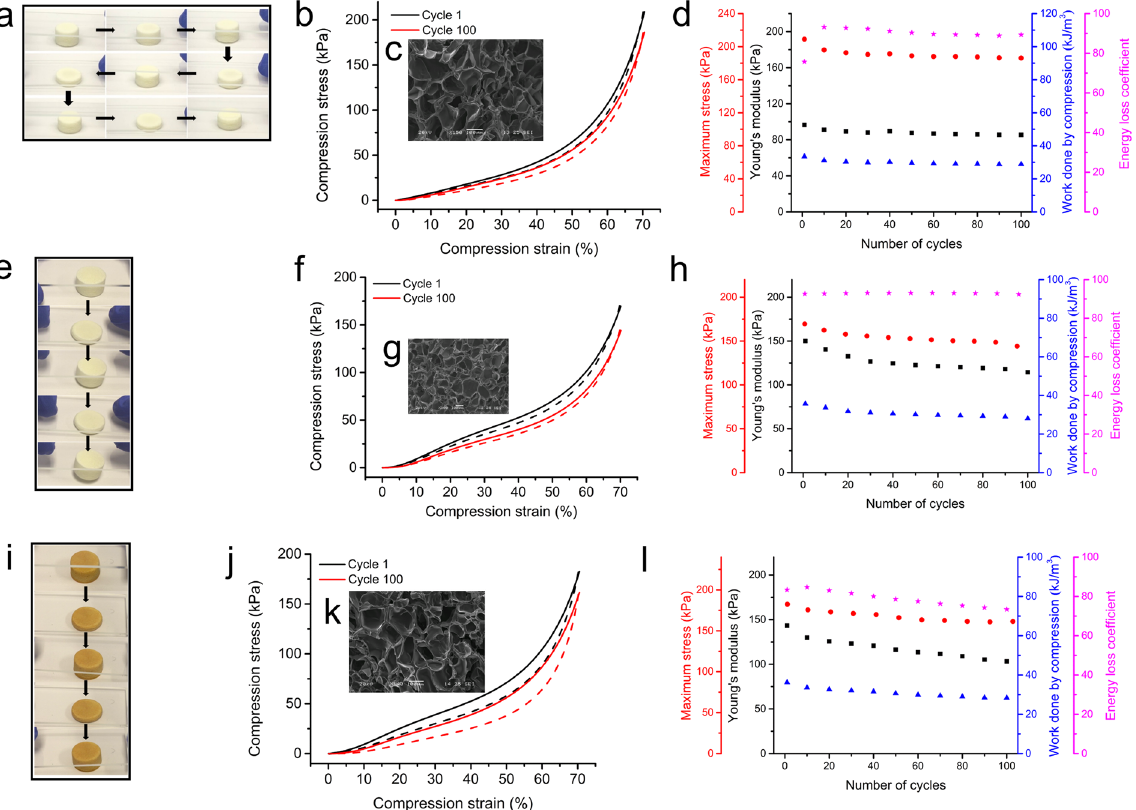
Figure 7. The ultra-fast recovery of high resilience of CG-G4-5% after storage at high and low temperatures. ( a ) A set of real-time images of a dendrimer cryogel sample after 24 h storage at − 80 °C showing the recovering process at cycle 1, 2, 3, and cycle 4. ( b , f , j ) Compressive stress-strain curves of cycle 1 and cycle 100 of loading (solid lines) and unloading (dashed lines) at 25 °C after storage at − 80, − 20, and 100 °C for 24 h. ( c ) The SEM images of dendrimer cryogel after storage at − 80 °C for 24 h and then being compressed 100 cycles. ( d , h , l ) Young’s modulus ( ■ ), maximum stress ( ), work done by compression ( ), and energy loss coefficient ( ) at different cycles during the 100 cycles of compression test after storage at − 80, − 20, and 100 °C for 24 h. ( e ) A set of real-time images of a dendrimer cryogel sample after 24 h storage at − 20 °C showing the recovering process at cycle 1 and 2. ( g ) The SEM images of dendrimer cryogel after storage at − 20 °C for 24 h and then being compressed 100 cycles. ( i ) A set of real-time images of a dendrimer cryogel sample after 24 h storage at 100 °C showing the recovering process at cycle 1 and 2. ( k ) The SEM images of dendrimer cryogel after storage at 100 °C for 24 h and then being compressed 100 cycles. Scale bars: 100 μ m ( c , g , k